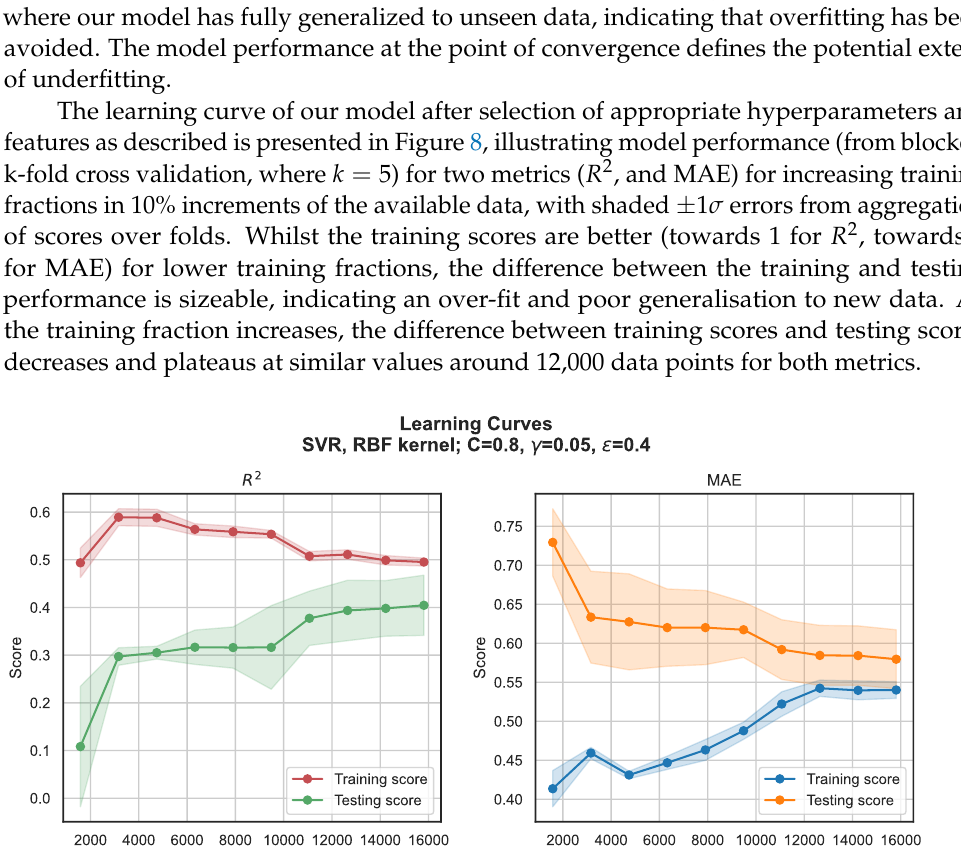
Figure 8. Learning curves for our regression model at specified hyperparameters and features, for the coefficient of determination R 2 (left) and mean absolute error (right). Demonstrates training and testing performance (from blocked k-fold cross validation, where k = 5) for increasing training fractions in 10% increments. Highlighted regions demonstrate ± 1 σ errors from averaging folds. Performance of testing and training scores exhibits convergence for increasing training fractions.